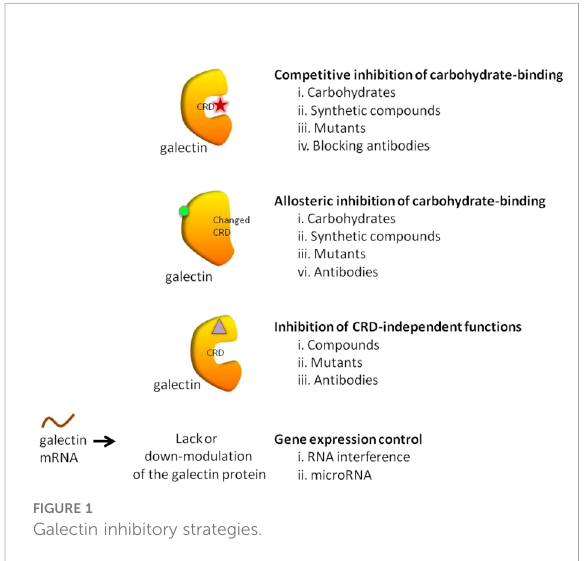
FIGURE 1 Galectin inhibitory